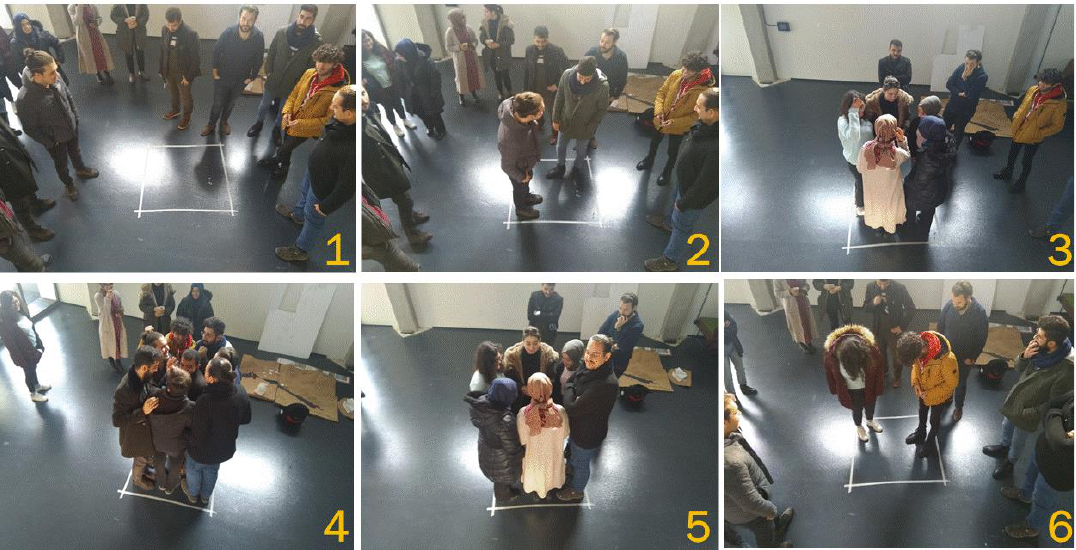
Figure 5 Personal space experiments where a 1x1 square is marked at the floor (1). Afterward, they start to test different loads such as the basic TS 12127 and TS 12186 load (2), crushing loads (3&4) followed by different case studies